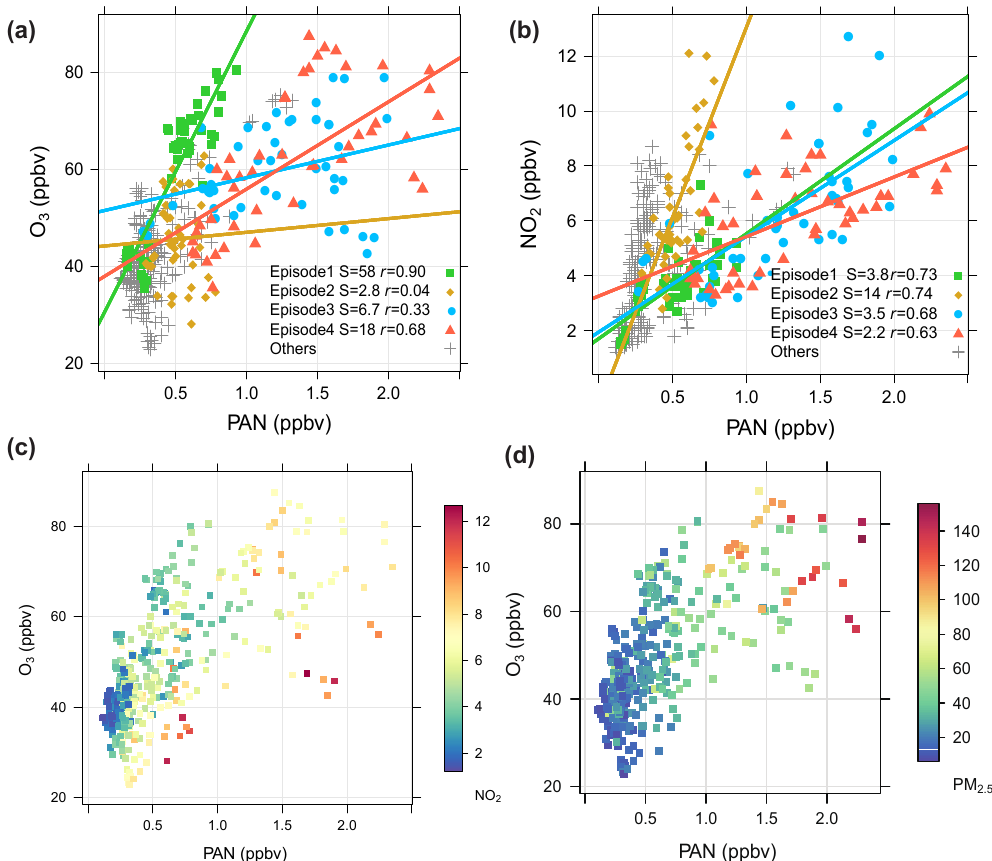
Figure 5. Correlations between (a) PAN and O 3 and (b) PAN and NO 2 with linear regression line for each episode. Correlations between O 3 and PAN were color-coded by the level of (c) NO 2 and (d) PM 2 . 5